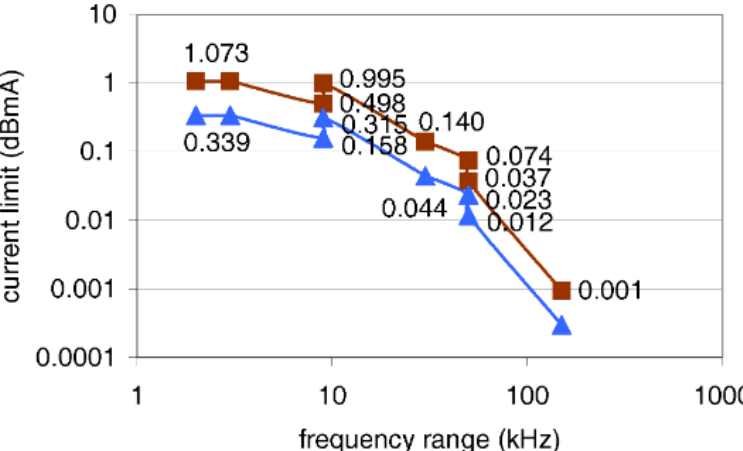
Figure 9. Extrapolated supraharmonic current limits based on CLs, estimated network impedance ˆ Z = 10 of concomitant sources with randomly distributed phase: overall limit with sh and number n n = 1 ( brown squares ), individual limit with n = 10 ( blue triangles